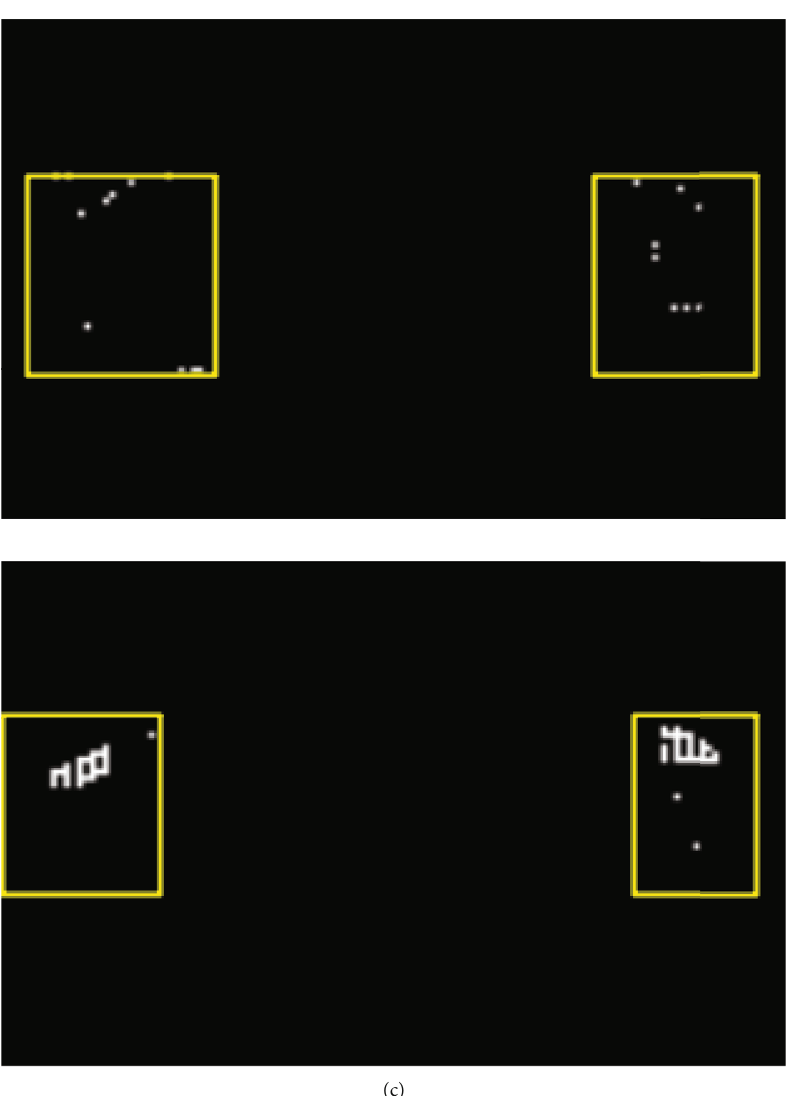
Figure 7: The APS frame of a detected vehicle and the corresponding synchronized event frame. The top row indicates that the taillight is ON, and the bottom row indicates that the taillight is OFF. (a) APS frame of a detected vehicle. (b) Synchronized event frame from raw DVS events of the vehicle in (a). (c) Synchronized event frame from fi ltered DVS events of the vehicle in (a). Table 1: Setting of parameter values used in the experiment.